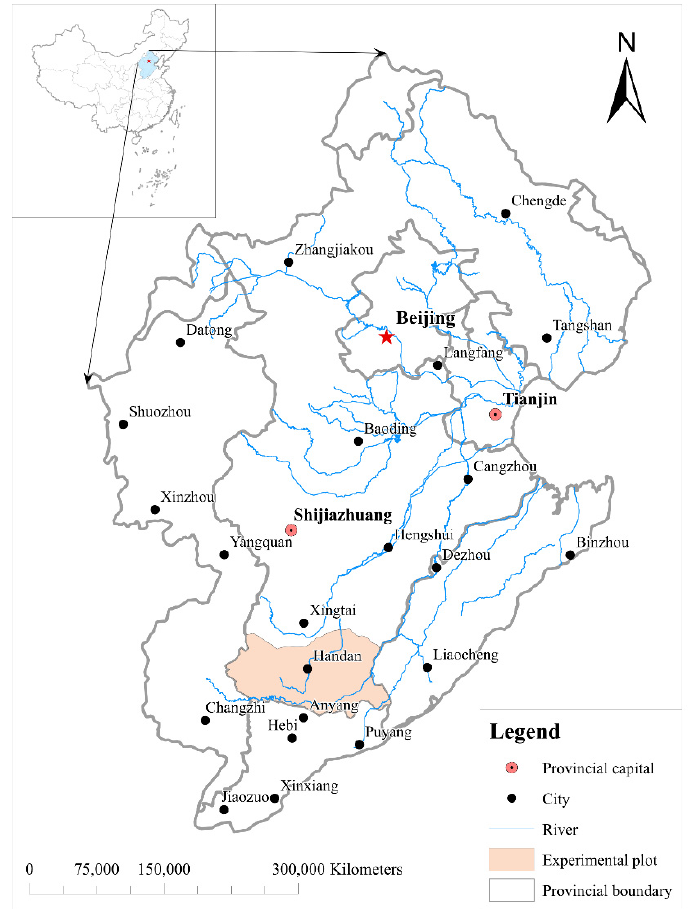
Figure 1. Location of the study area in the Haihe Watershed, Hebei Province, China.